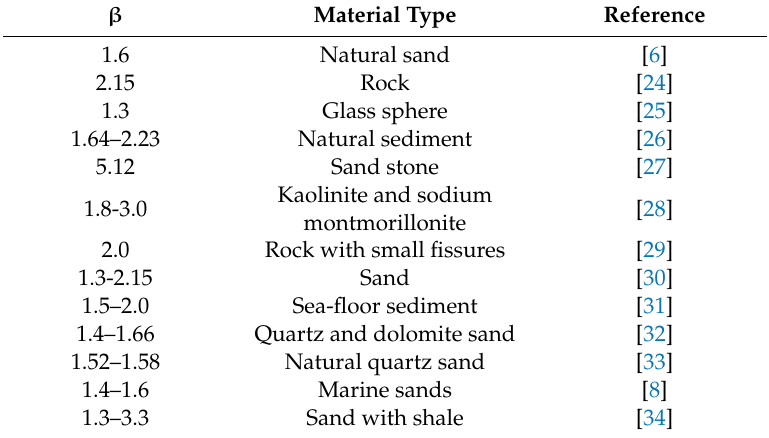
Table 1. Suggested ranges of the cementation factor ( β ), derived from previous